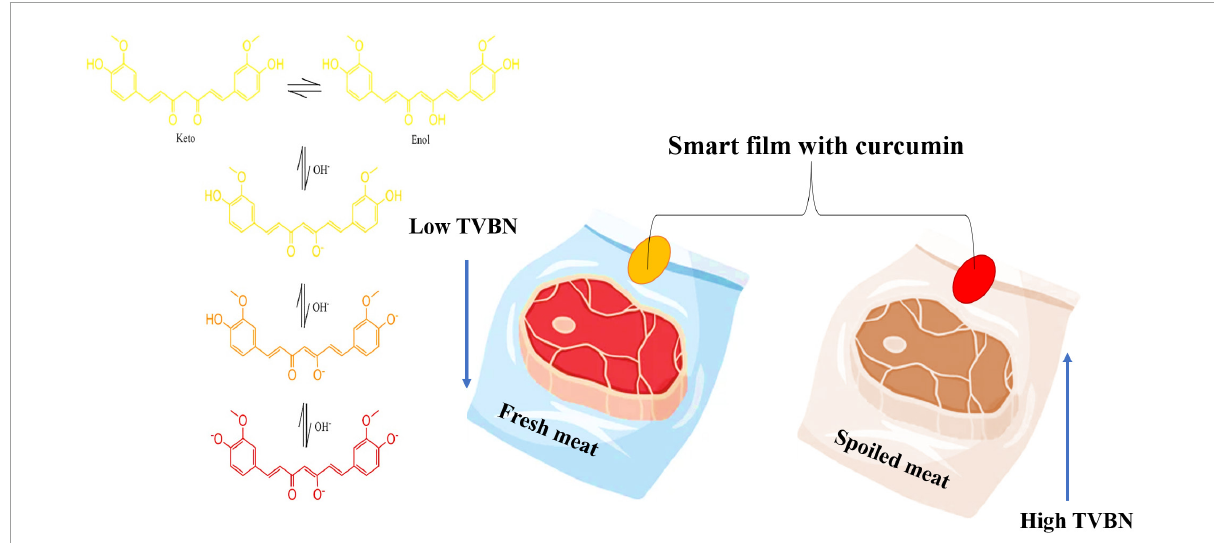
FIGURE2 The effect of pH on curcumin color and its application in food shelf-life. TVBN, Total volatile base nitrogen.